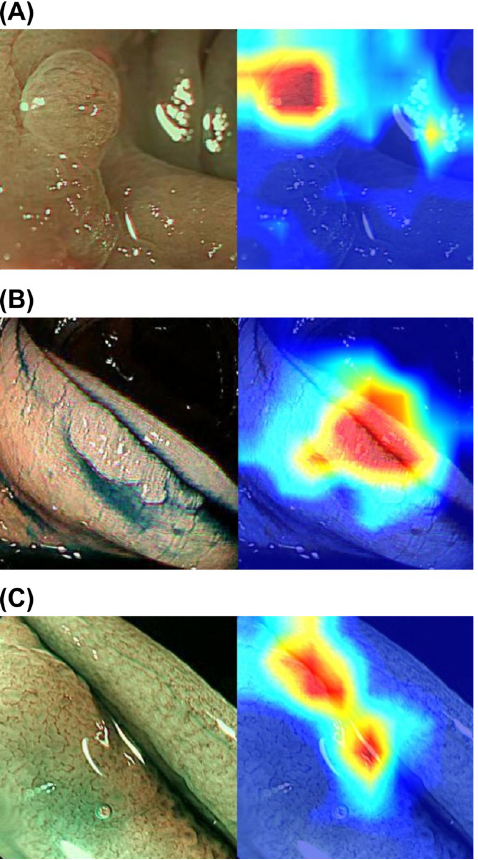
Fig 4. Polyp recognition. (A) A case of a non-adenomatous hyperplastic polyp. (B) A case of an adenomatous polyp. (C) A case of an adenomatous polyp. PPV = Total real adenoma images in total number images of second AlexNet or ResNet diagnosed as adenoma / Total number images of second AlexNet or ResNet diagnosed as adenoma.